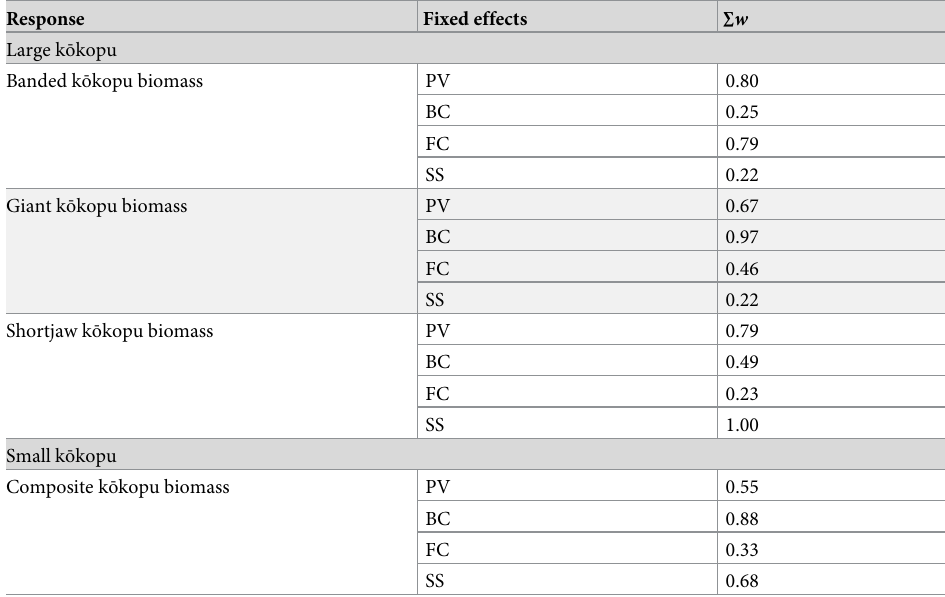
Table 2. Relative importance of habitat features affecting the biomass of large banded k ō kopu, giant k ō kopu, and shortjaw k ō kopu and composite small k ō kopu size classes.